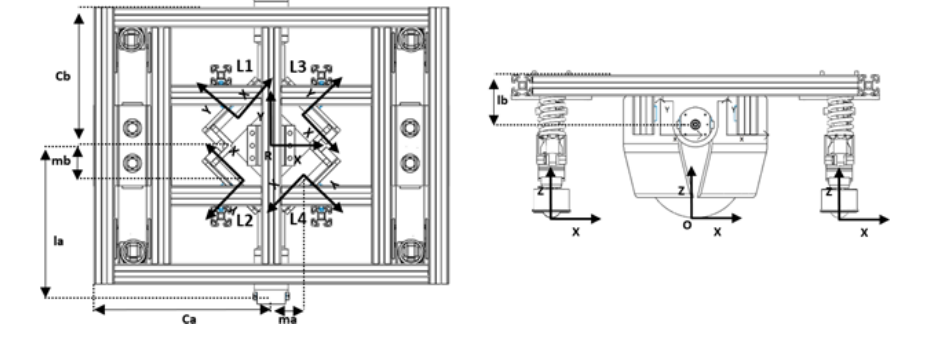
Figure 6. Coordinate system assignment.